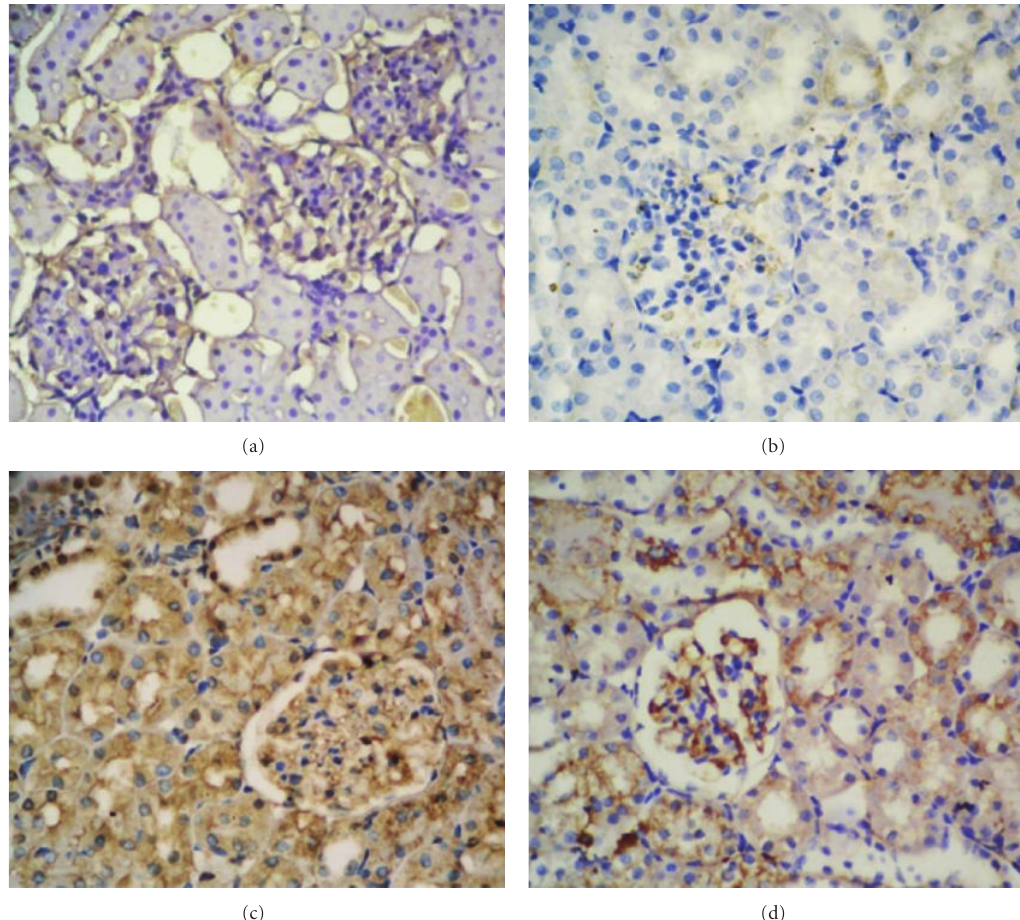
Figure 5: (a) and (b) iNOS control and nicotinamide (NAD), (c) Doxorubicin (DXR), (d) DXR+NAD.